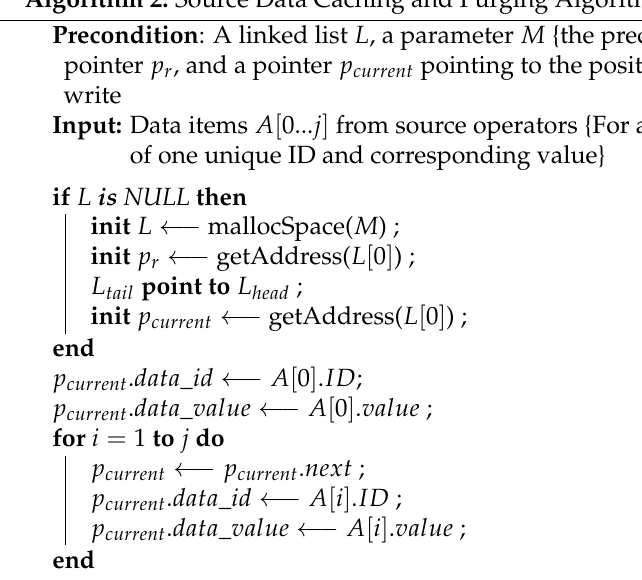
Algorithm 2: Source Data Caching and Purging